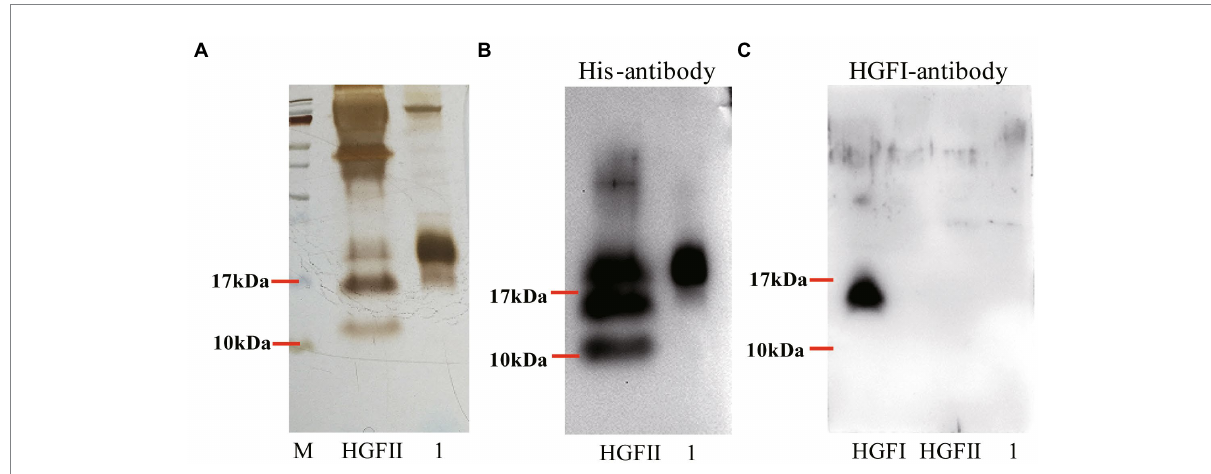
FIGURE 3 Purification of HGFII with His-tag in P. pastoris . (A) SDS-PAGE assay of HGFII. Western blot identification of HGFII with His-antibody (B) , and HGFI- antibody (C) . Lane “HGFII” is a crude extract of HGFII, lane 1 is pure HGFII after ultrafiltration and Ni-IDA purification.